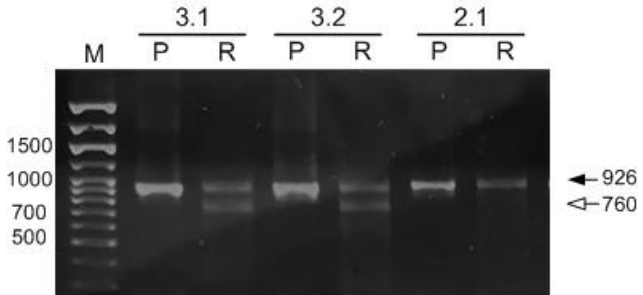
Figure 3. The electrophoretic pattern of separation in 1.5% agarose gel of PCR fragments of the αCA4 gene of T2 plants before and after treatment with Asp S9I restriction enzyme. Designations: 3.1, 3.2, 2.1 are the numbers of the respective plants; M‒DNA marker Step 100 Long (Biolabmix, Russia), lengths of fragments in bp are indicated on the left; (P)‒PCR fragment of the αCA4 gene of the re- spectiv e plants, and (R)‒ Asp S9I restriction of the corresponding PCR fragments of the αCA4 gene. The black arrow indicates the initial PCR fragment; the white arrow indicates the fragment obtained after Asp S9I digestion. Sizes of the fragments are indicated in bp.